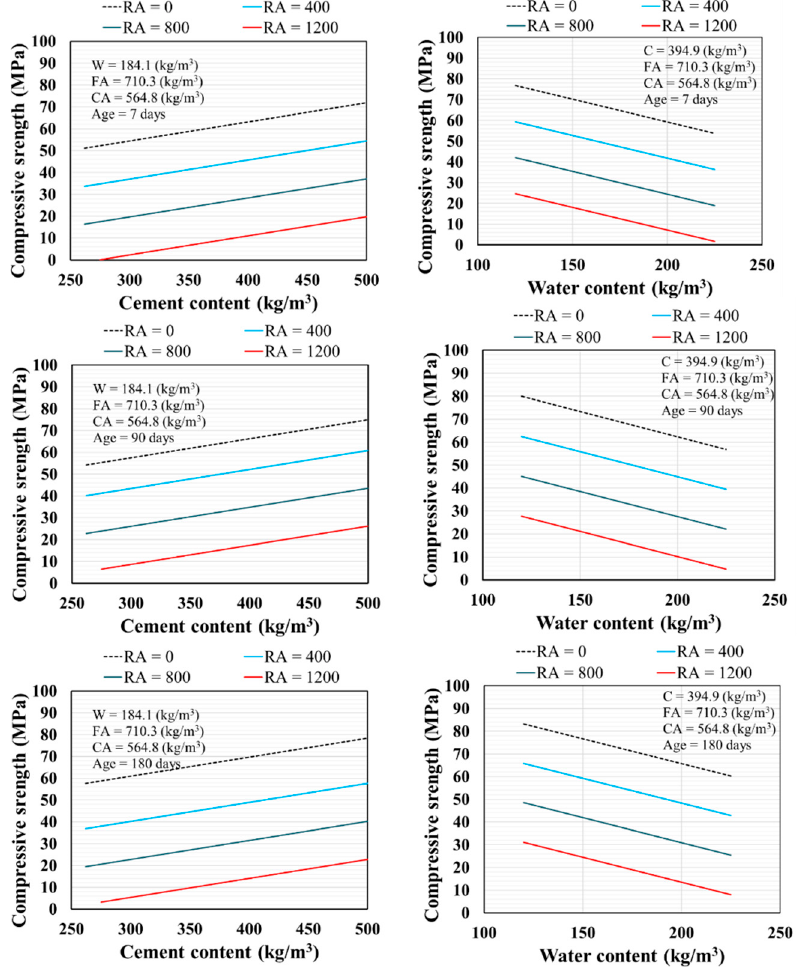
Figure 13. Parametric study for trends of RCDWAC mixtures at different water and cement contents versus curing time.